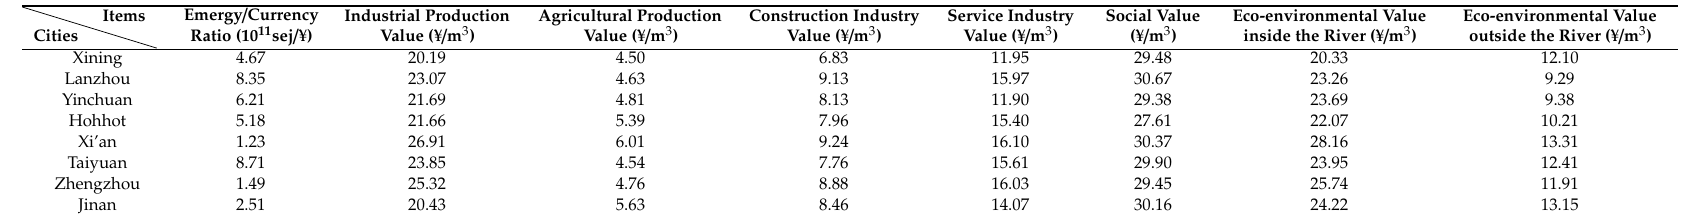
Table 4. Water resource values of typical cities in the Yellow River Basin in 2015.